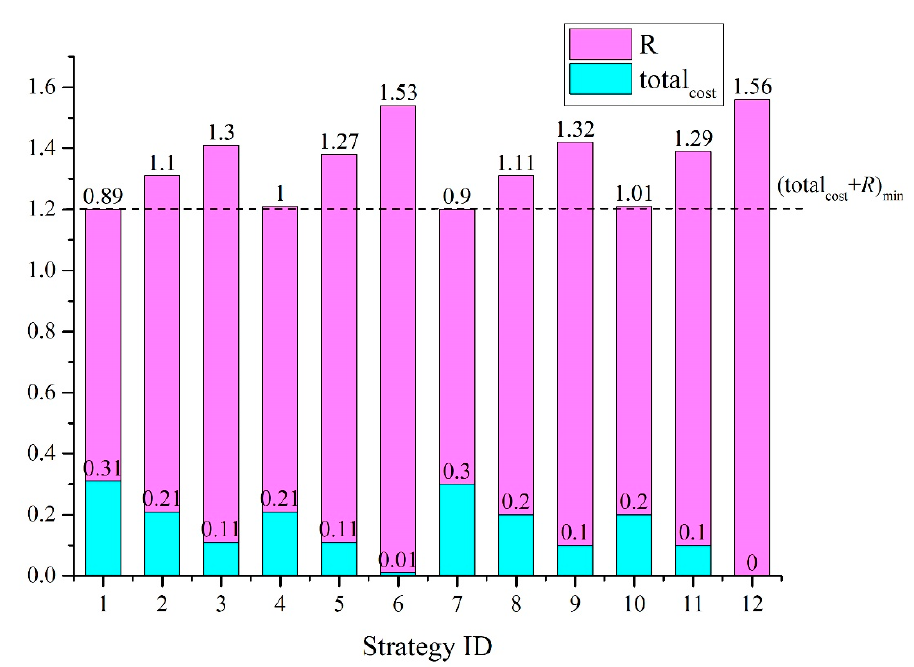
Figure 8. The total cost and R values and their sum for each risk treatment strategy.